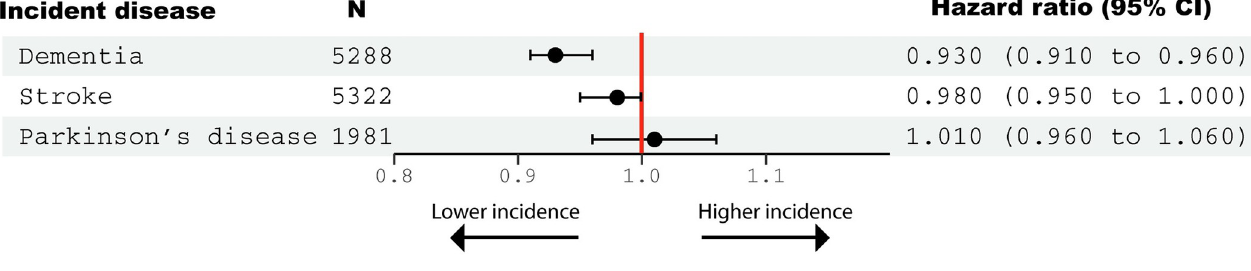
Fig 4. Associations between leucocyte telomere length (quantile normalized) and incident disease during follow up. Hazard ratios (95% confidence intervals) were generated from Cox proportional hazards models adjusted for: Age, age 2 , age 3 , sex, body mass index, educational qualifications, Townsend Deprivation Index, household income, historical job code, smoking, alcohol intake, leucocyte count, genetic ancestry.